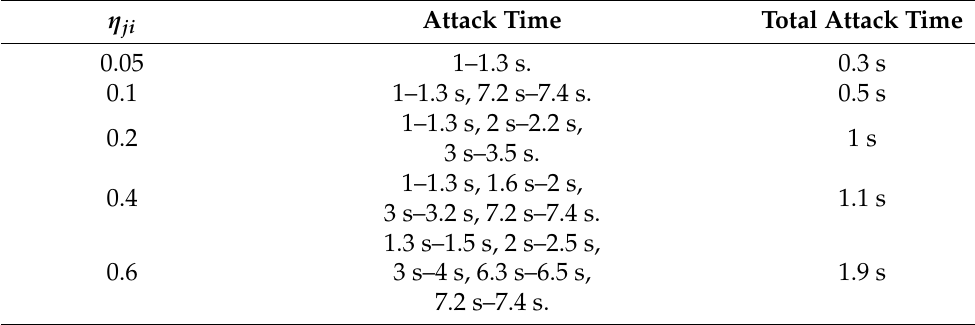
Table 2. DoS attack period and total attack time under different data packet loss